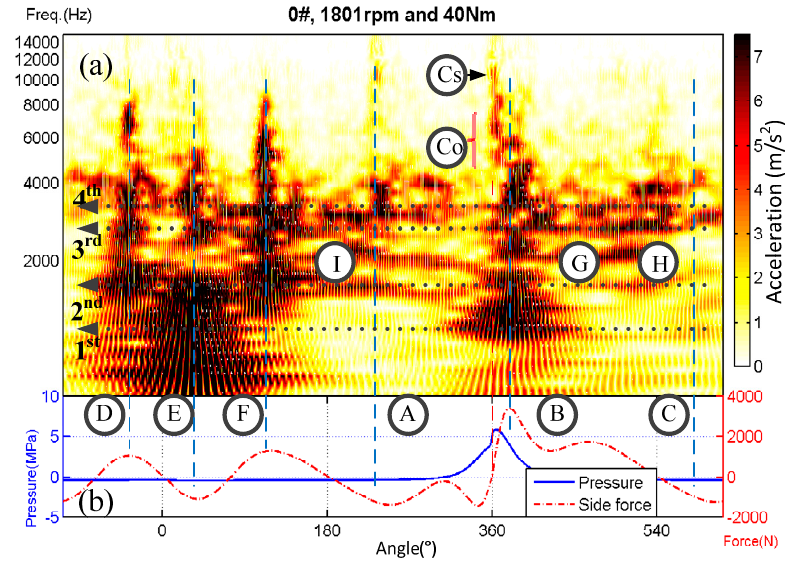
Figure 19. Continuous wavelet transform (CWT) of vibration signal fueled with diesel under 40 Nm and 1800 rpm: ( a ) CWT result of measured acceleration response; ( b ) Measured in-cylinder pressure and calculated piston side-thrust force.